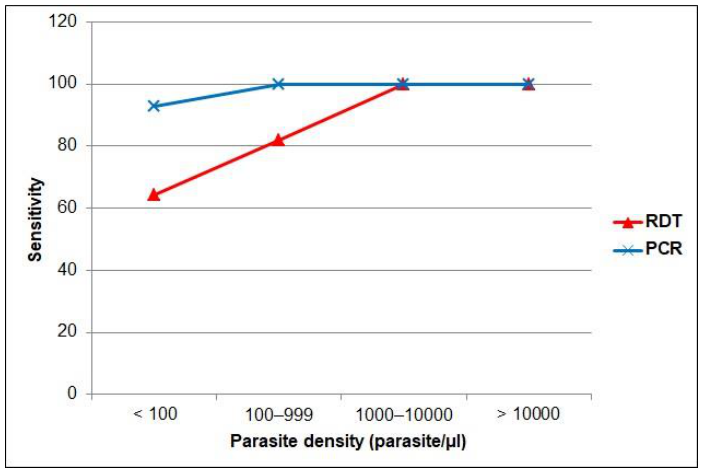
Figure 3. Sensitivity by parasite density level of the RDT and PCR versus microscopy as gold standard. Table 4. Performance according to participants’ characteristics of RDT and light microscopy tech- niques in the diagnosis of falciparum malaria against PCR as reference method.